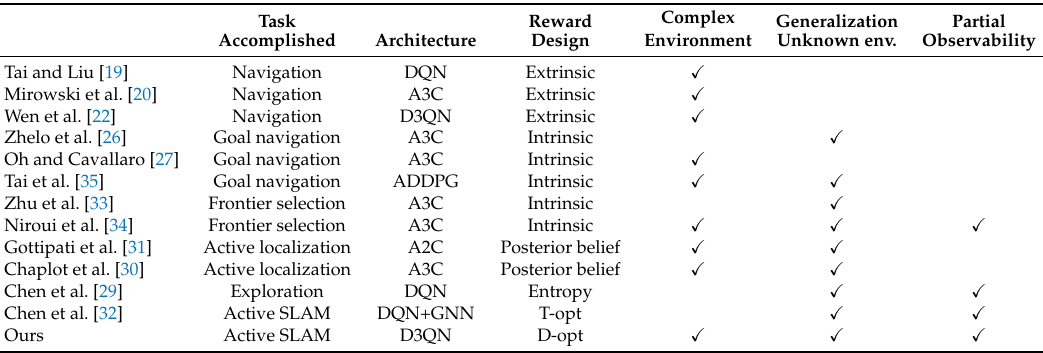
Table 1. Comparison with prior